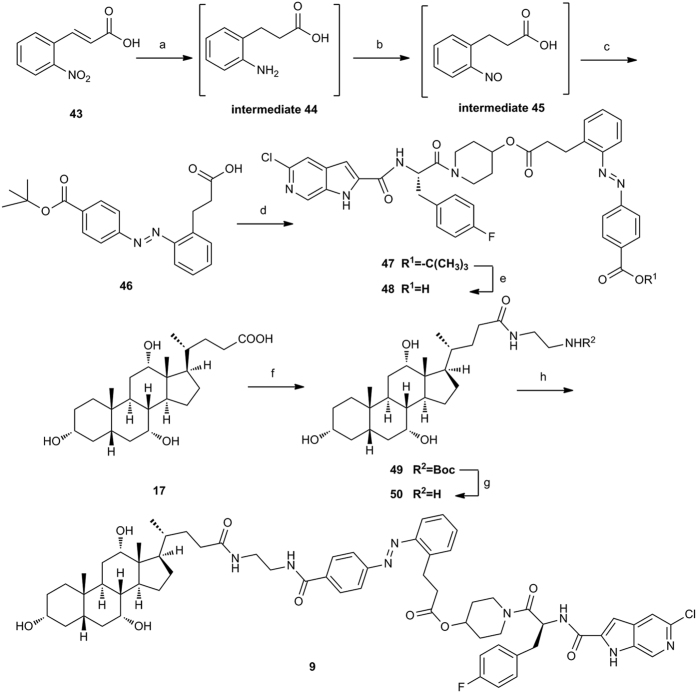
Synthesis of conjugate 9a.Reagents and conditions: (a) H2, Pd/C, NaOH, rt; (b) Oxone, H2O/CH2Cl2; rt; (c) tert-Butyl 4-aminobenzoate, AcOH, 80 °C, 3 steps 17.4% yield for 46; (d) PSN-357, DCC, DMAP, CH2Cl2, rt, 82.9%; (e) TFA, CH2Cl2, rt, 79.5%; (f) N-Boc-ethylenediamine, DEPC, Et3N, DMF, 0 °C to rt, 74%; (g) HCl/MeOH, 0 °C to rt, 97%; (h) 48, HATU, DIPEA, DMF, rt, 10.4%.